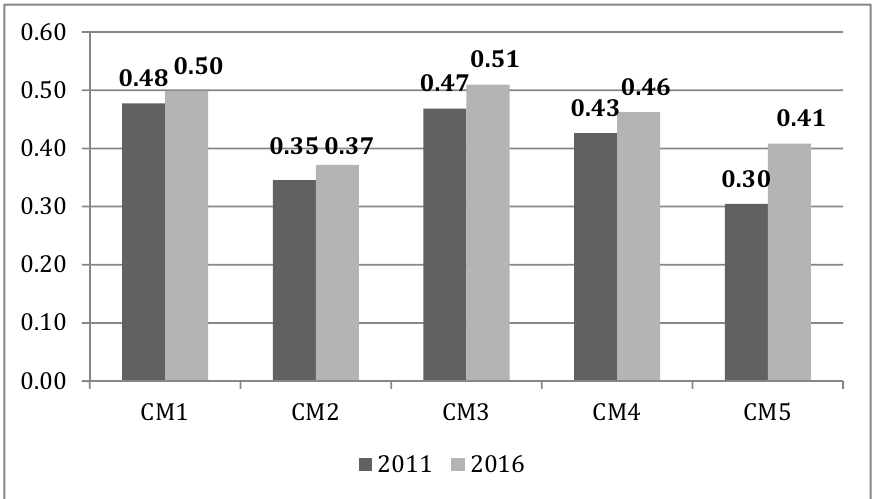
Figure 7. The results of the assessment of economic criteria in 2011 and 2016 in the examined hard coal mines. Source: own work.